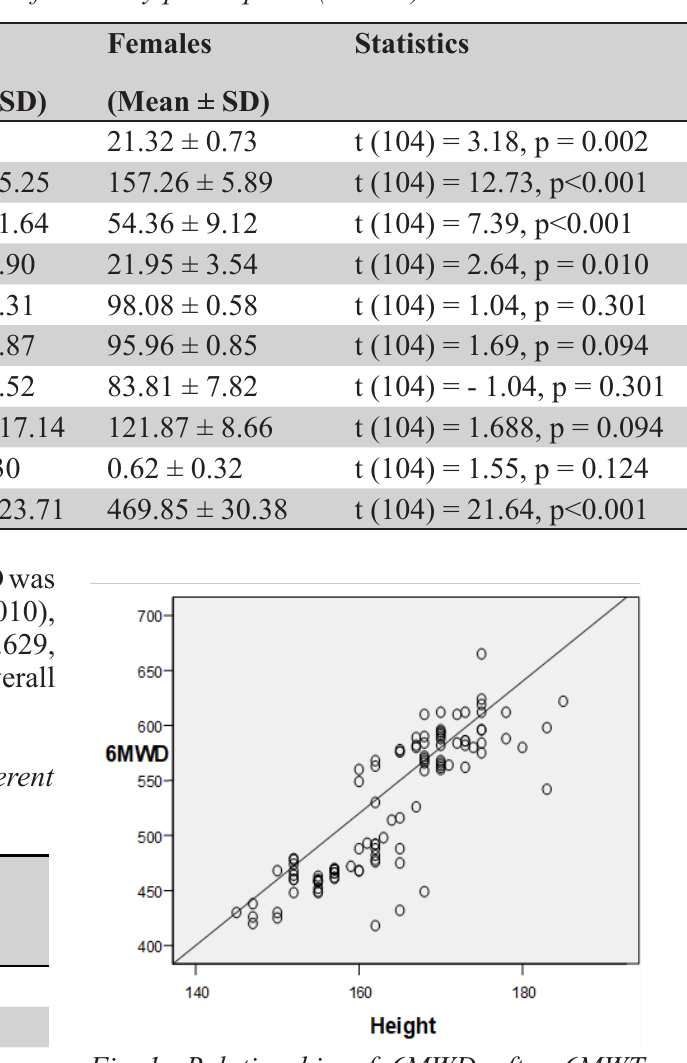
Fig 1: Relationship of 6MWD after 6MWT and Height